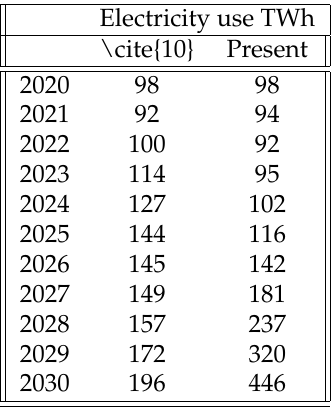
Table 3. Differences between [3] expected case and the present prediction for mobile networks.